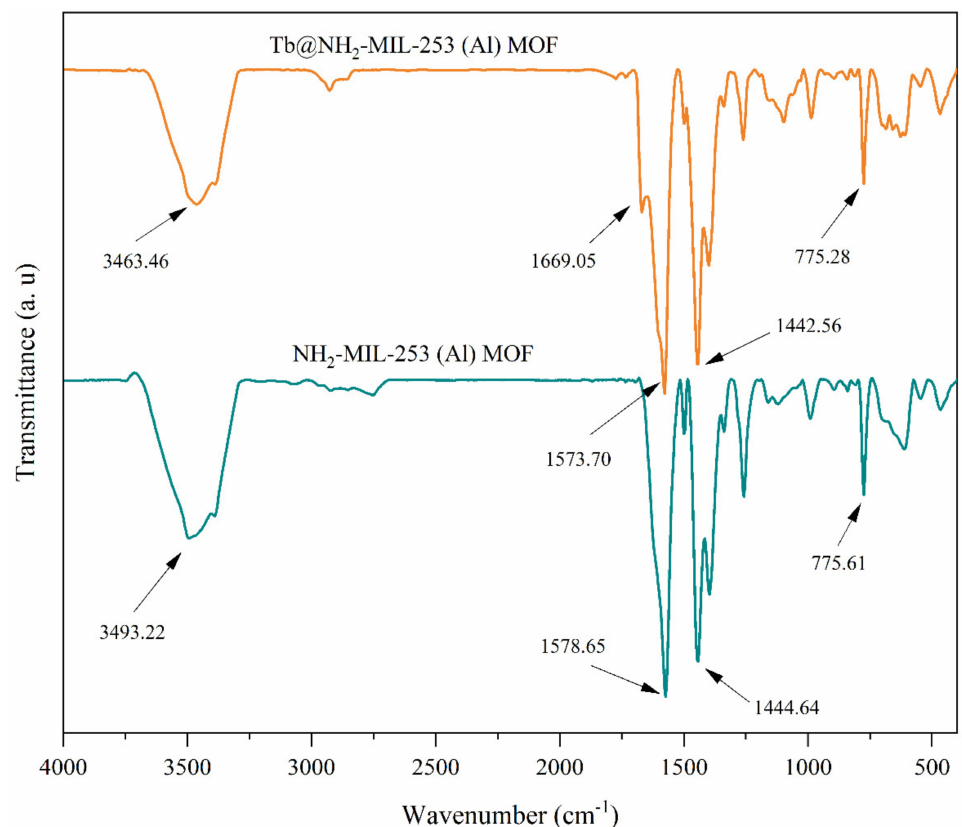
Figure 2. FTIR spectra of Tb@NH 2 -MIL-253 (Al) MOF, and NH 2 -MIL-253 (Al) MOF fluores- cence